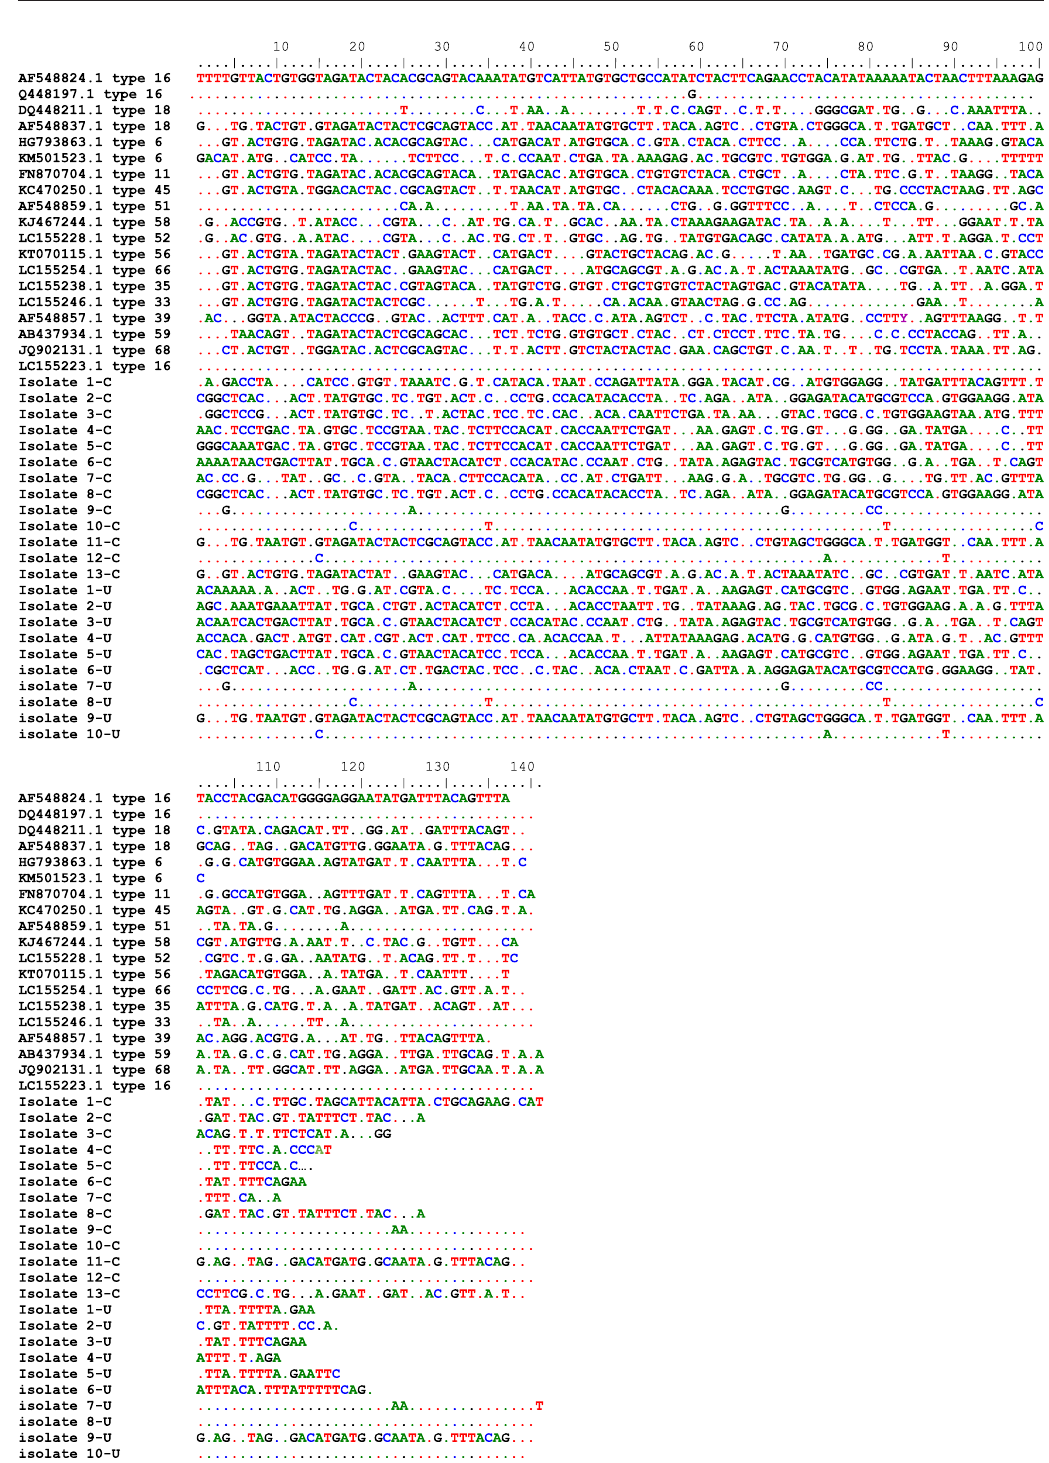
Fig. 3. Alignment of local isolates with reference sequences using BioEdit software. C:cervical swab, U: urine